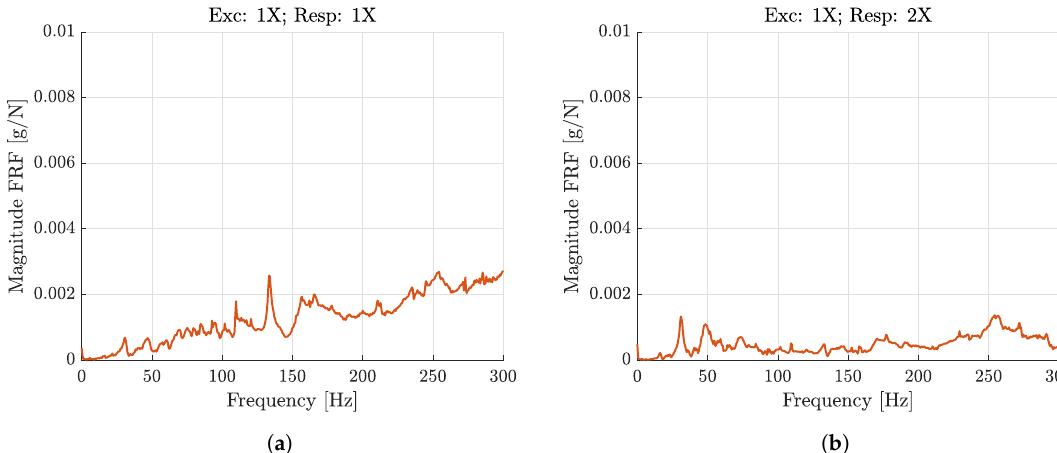
Figure 8. FRFs of Z-rail (Figure 6): ( a ) direct (excitation 1X, response 1X), ( b ) cross (excitation 1X, response